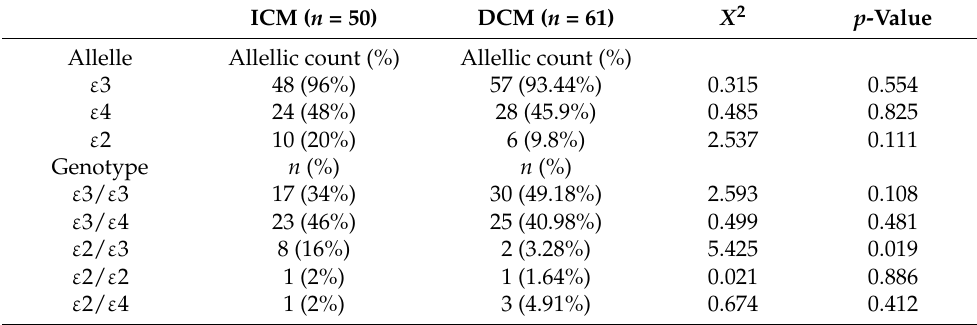
Table 3. The apoE genotype based on CM